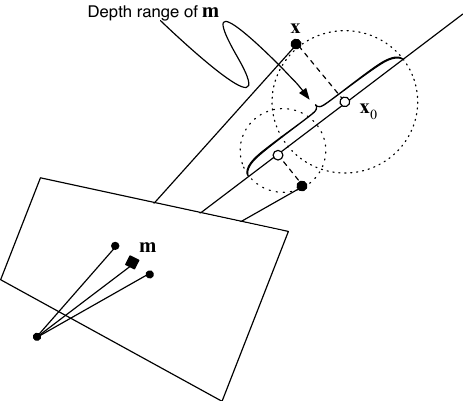
Figure 2: The depth range of a pixel m (black square) is estimated using the closest keypoints (black circles). Every keypoint have a corresponding 3D point x , which projects onto the optical ray of m at x 0 and produces a depth interval of radius || x  x 0 || centered at x 0 . The union of these intervals is the depth range of m . of the pixel. The search range along the optical ray is defined as the union of the (five) intervals with center in x o and radius